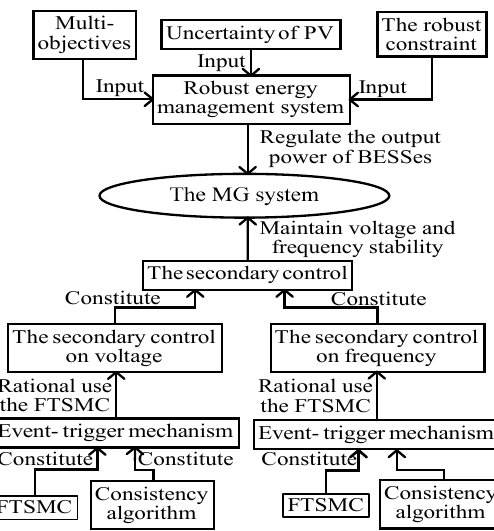
Figure 1. The integrated design of control and energy management.